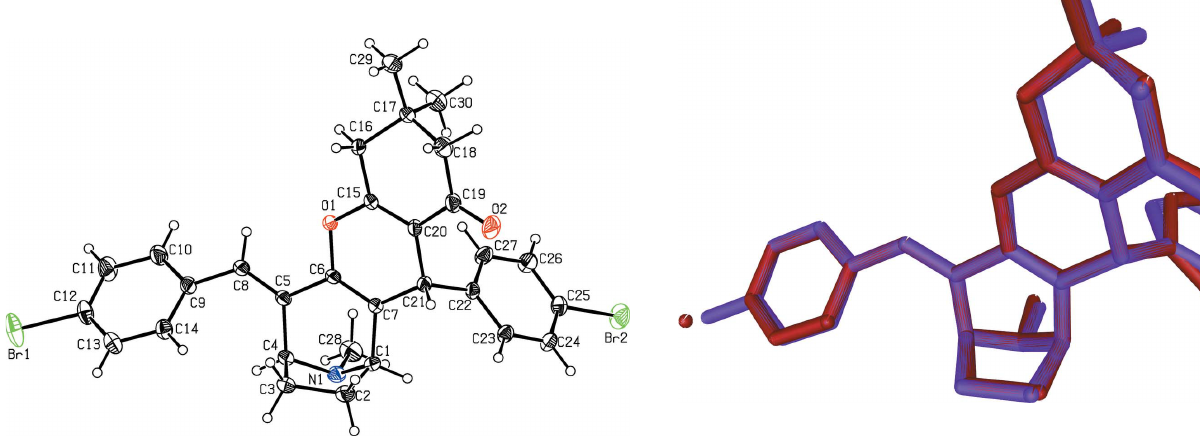
Figure 2 A view of the molecular structure of compound (II), showing the atom labelling. Displacement ellipsoids are drawn at the 30% probability level.